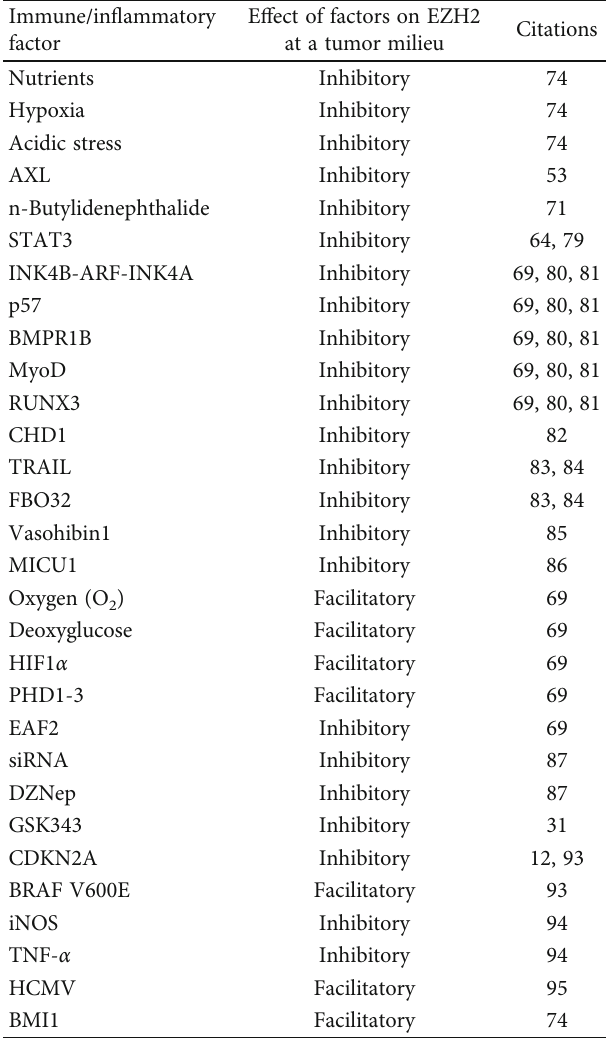
Table 1: Immune/in fl ammatory factors and their in fl uential e ff ects on